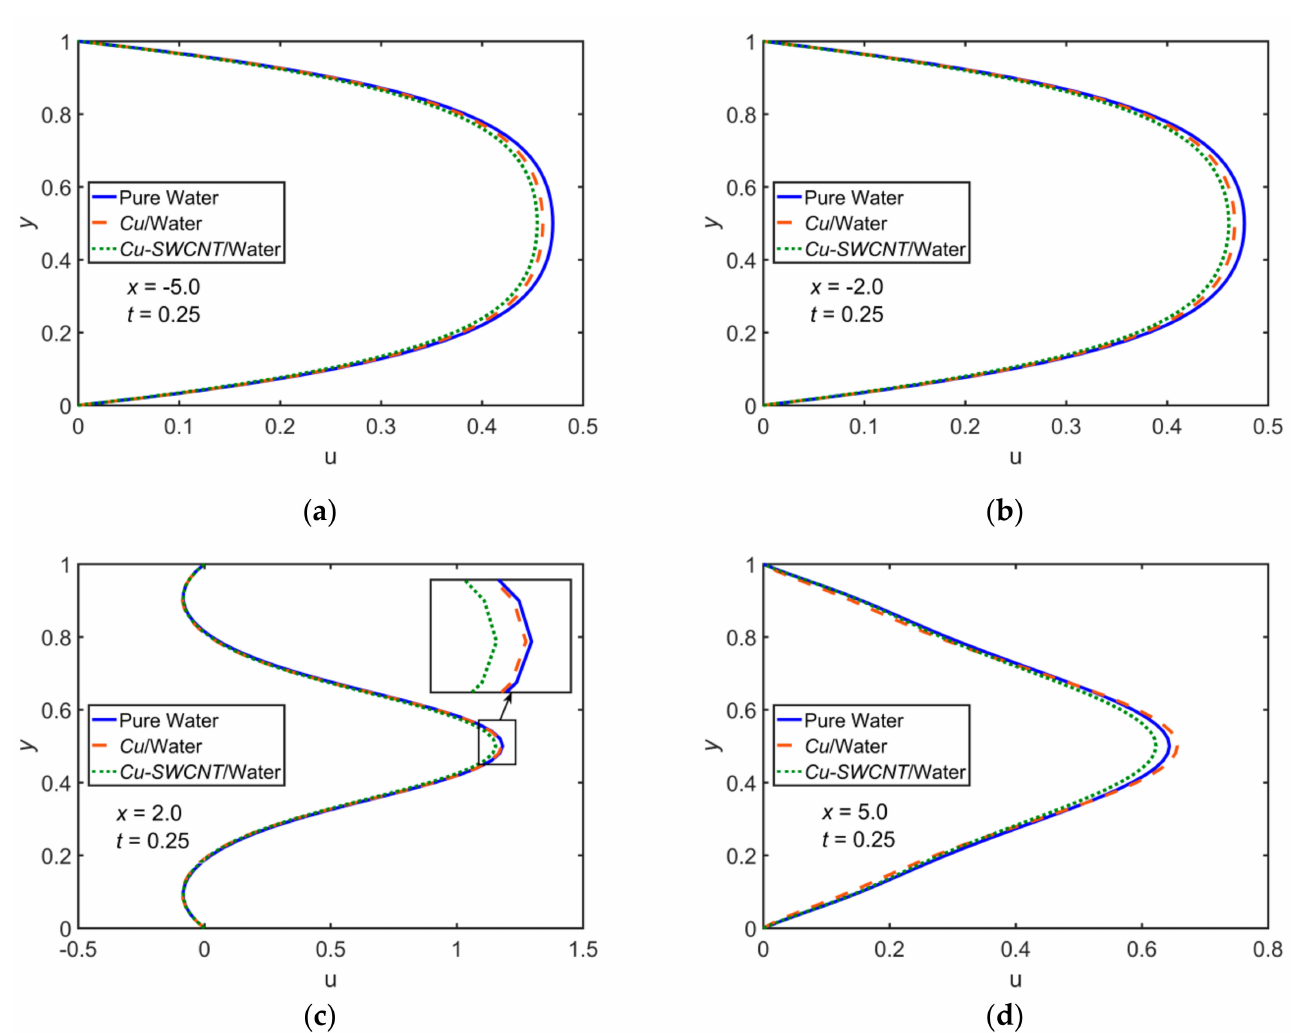
Figure 5. Comparison of pure water, Cu /water, and Cu – SWCNT /water for velocity profiles for M = 5, Pr = 1, Rd = 0.2, Re = 700, φ = 0.02, and t = 0.25 at ( a ) x = − 5.0, ( b ) x = − 2.0, ( c ) x = 2.0, and ( d ) x =